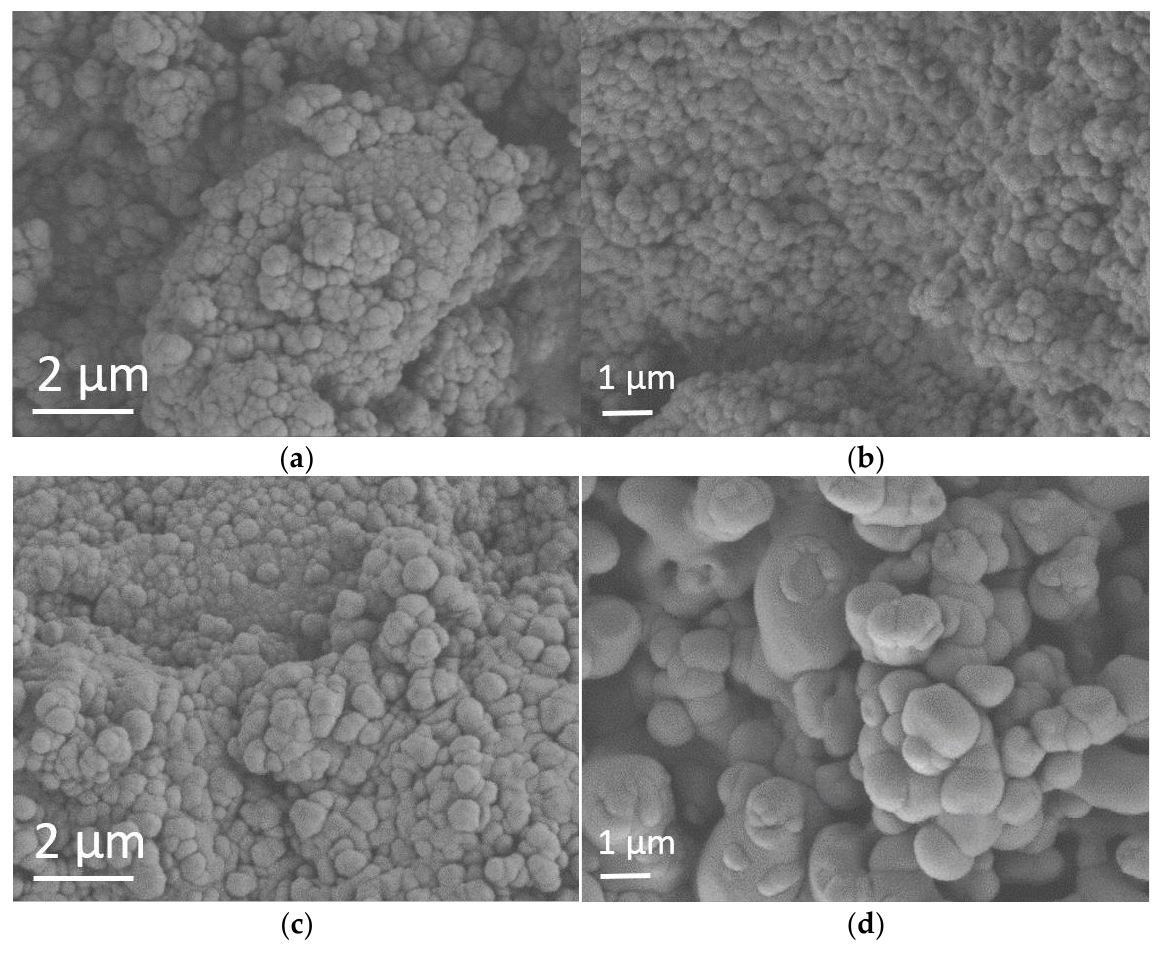
Figure 5. Micrographs of CPP/CC (Ca 2 P 2 O 7 ·xH 2 O/CaCO 3 ) powders synthesized from mixed-anionic solution before ( a ) and after firing at 600 °C ( b ), 700 °C (c), and 800 °C ( d ). Micrographs of ceramic chips were made for samples of Ca 2 P 2 O 7 ·xH 2 O/CaCO 3 fired